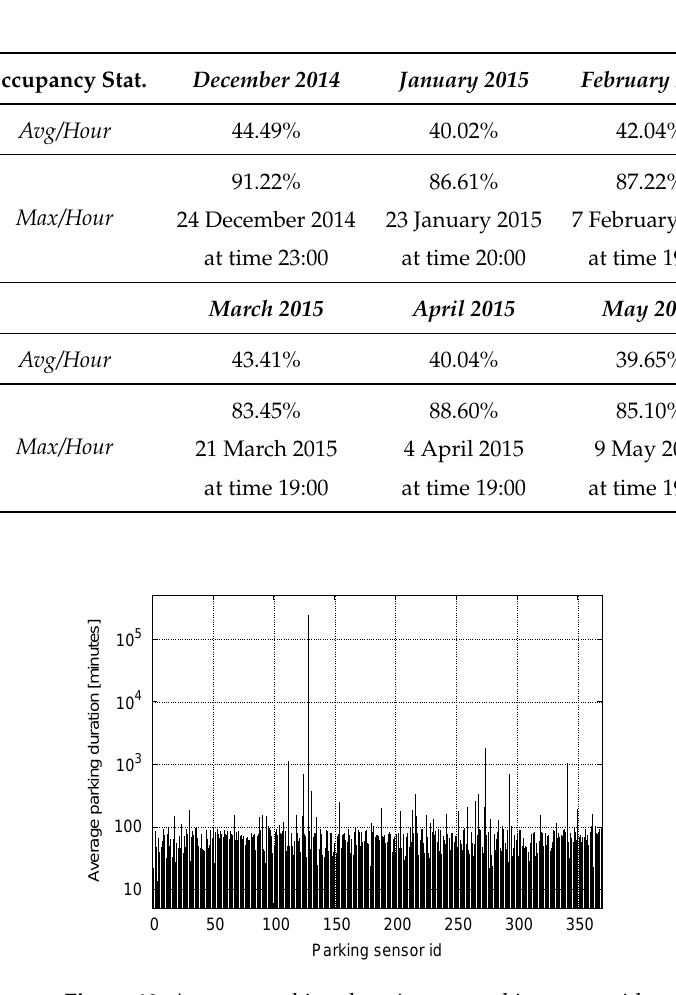
Table 3. Average and Max occupancy per hour for the six months in the dataset (December 2014 to